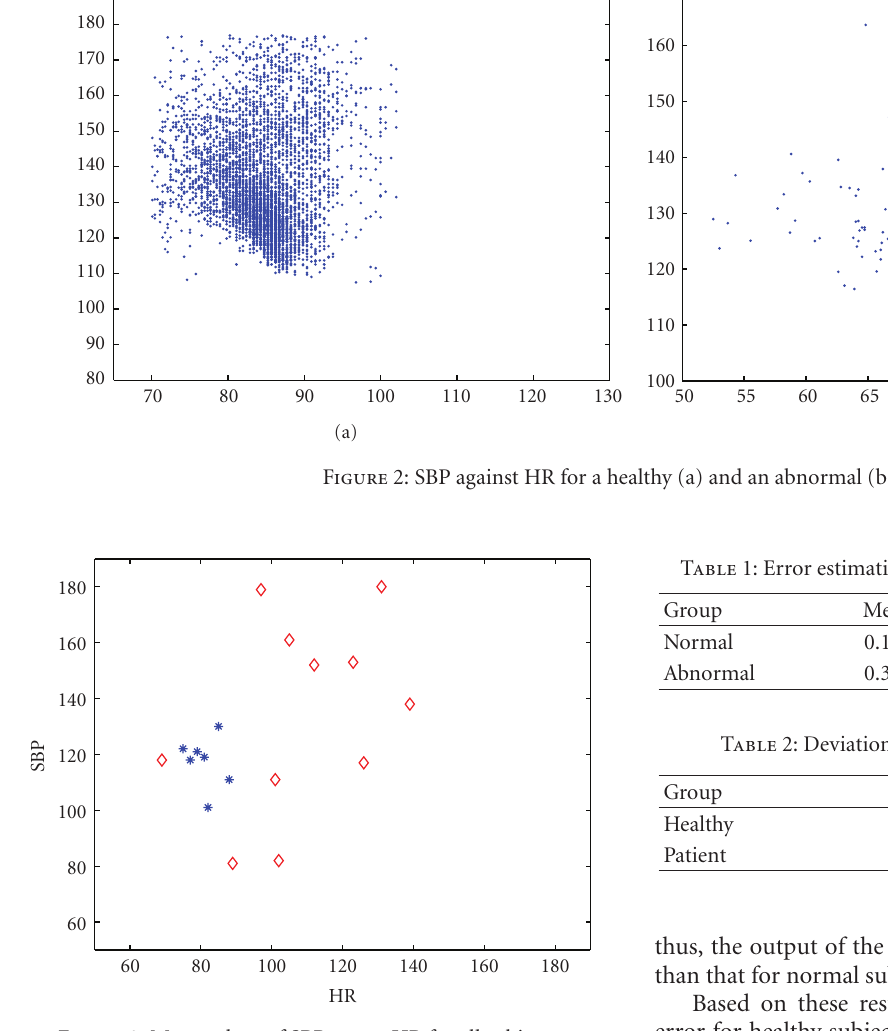
Figure 3: Mean values of SBP versus HR for all subjects.